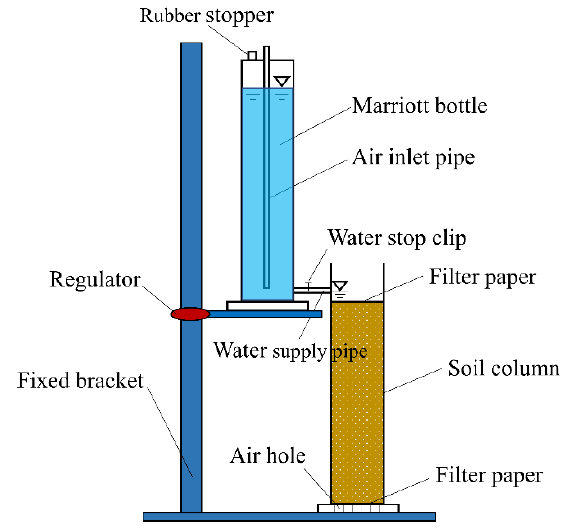
Figure 1. Schematic diagram of the experimental system.